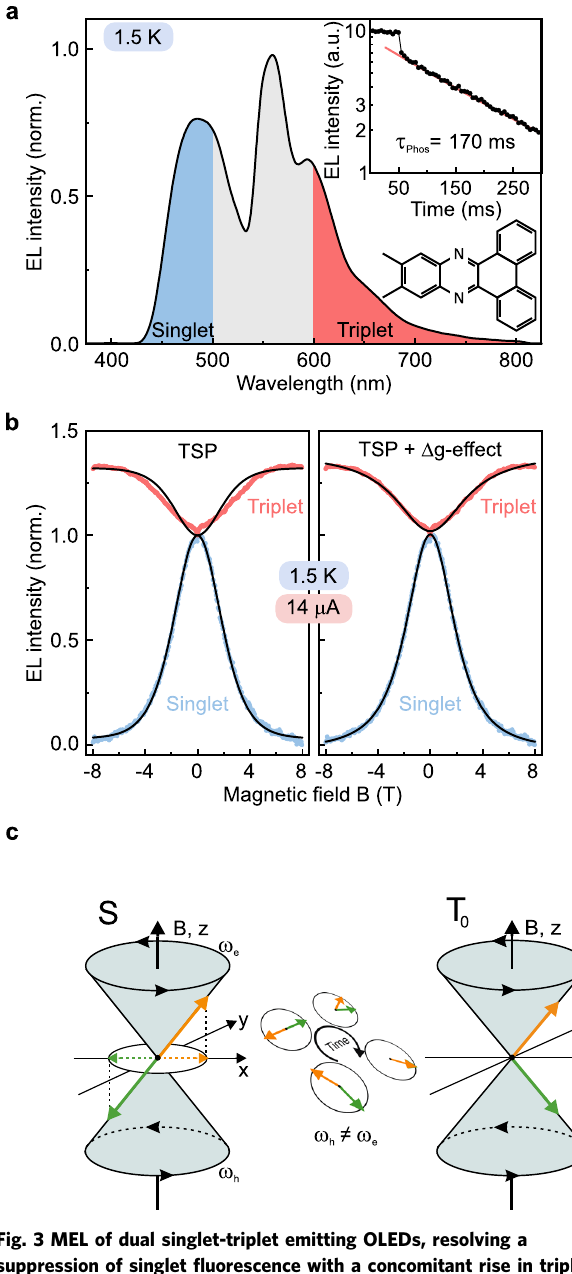
Fig. 3 MEL of dual singlet-triplet emitting OLEDs, resolving a suppression of singlet fl uorescence with a concomitant rise in triplet phosphorescence. a EL spectrum of an OLED with the dual emitter DMDB- PZ co-evaporated with CBP, at 1.5 K. The shaded regions indicate the spectral range selected by fi lters to distinguish between fl uorescence (blue) and phosphorescence (red). The inset shows a transient EL measurement, revealing a triplet phosphorescence lifetime of 170 ms. b Change of singlet and triplet luminescence intensity at 1.5 K under a device current of 14 µ A, with a fi t of the Boltzmann-TSP function [Eq. (3)] and a fi t of the TSP functionality modi fi ed for the Δ g effect [Eq. (4)]. c Sketch of the singlet- triplet mixing process in the pair due to the Δ g